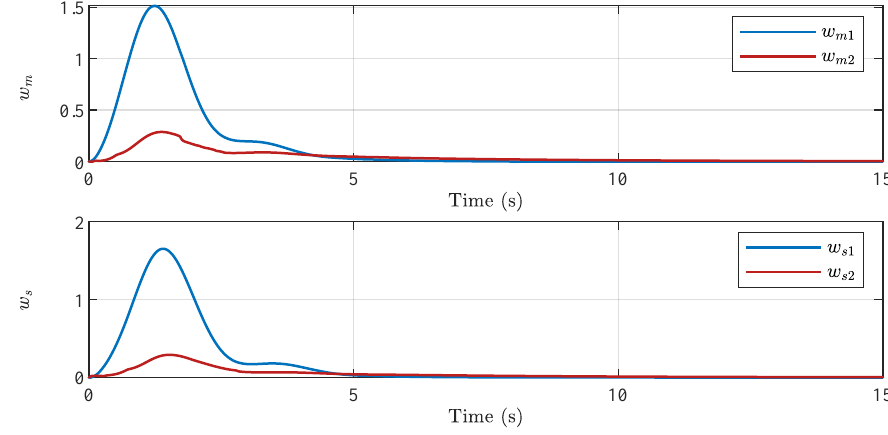
Figure 9. Adaptive parameters of ˆ w m and ˆ w s